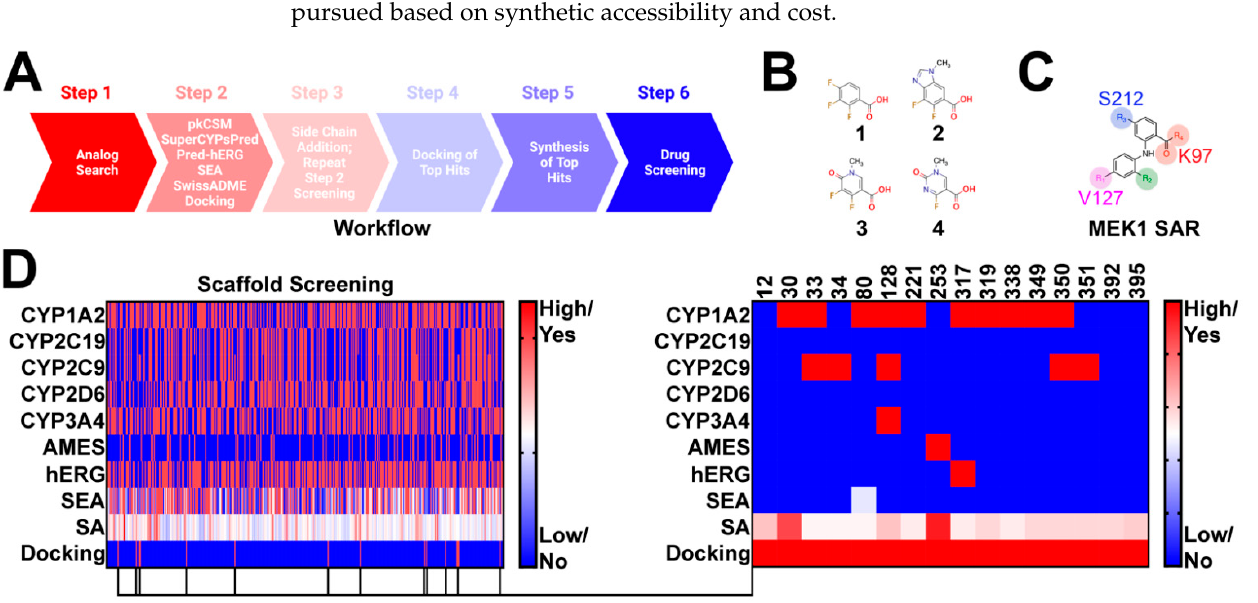
Figure 1. Identification of Novel synthetic intermediates: ( A ) workflow used to design novel Norris Lab (NL) compounds. The worklow included 6 steps: (1) analog search using synthetic intermediates derived from FDA-approved MEK1 inhibitors as bait, (2) filtering of synthetic intermediates, followed by PK predictions, (3) novel side-chain addition with repeat PK analysis, (4) docking of hits that emerged from step 3, (5) synthesis of top hits, and (6) drug screening; ( B ) structures used in synthetic intermediates identification. Advanced intermediated were derived from cobimetinib (1), binimetinib and selumetinib (2), TAK-733 (3), and trametinib (4); ( C ) figure highlighting the common structure activity relationship (SAR) shared among nanomolar range MEK1 inhibitors; ( D ) heat map demonstrating PK predictions on the 395 synthetic intermediates discovered. 16 synthetic intermediates were identified; however, only five of the synthetic intermediates were selected based on synthetic accessibility and cost.